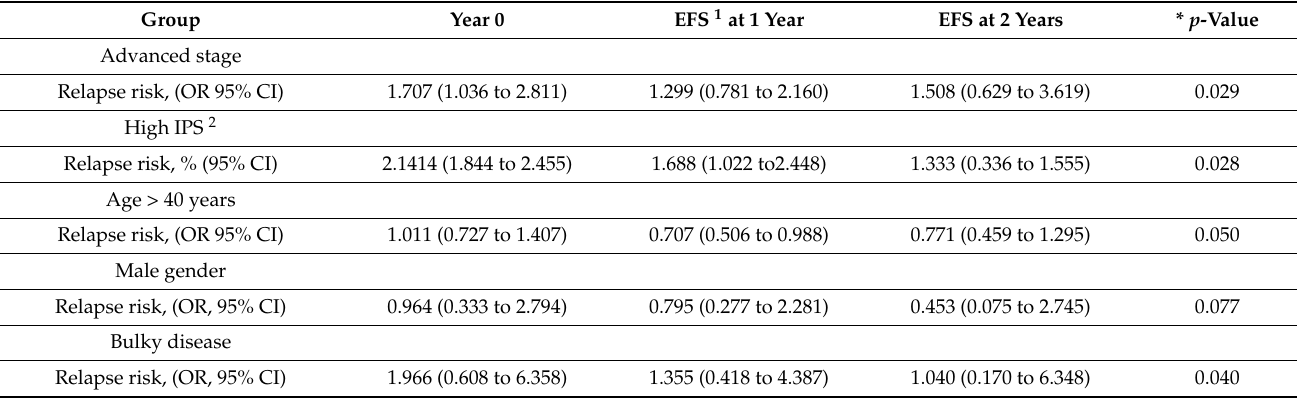
Table 2. Factors associated with the relapse